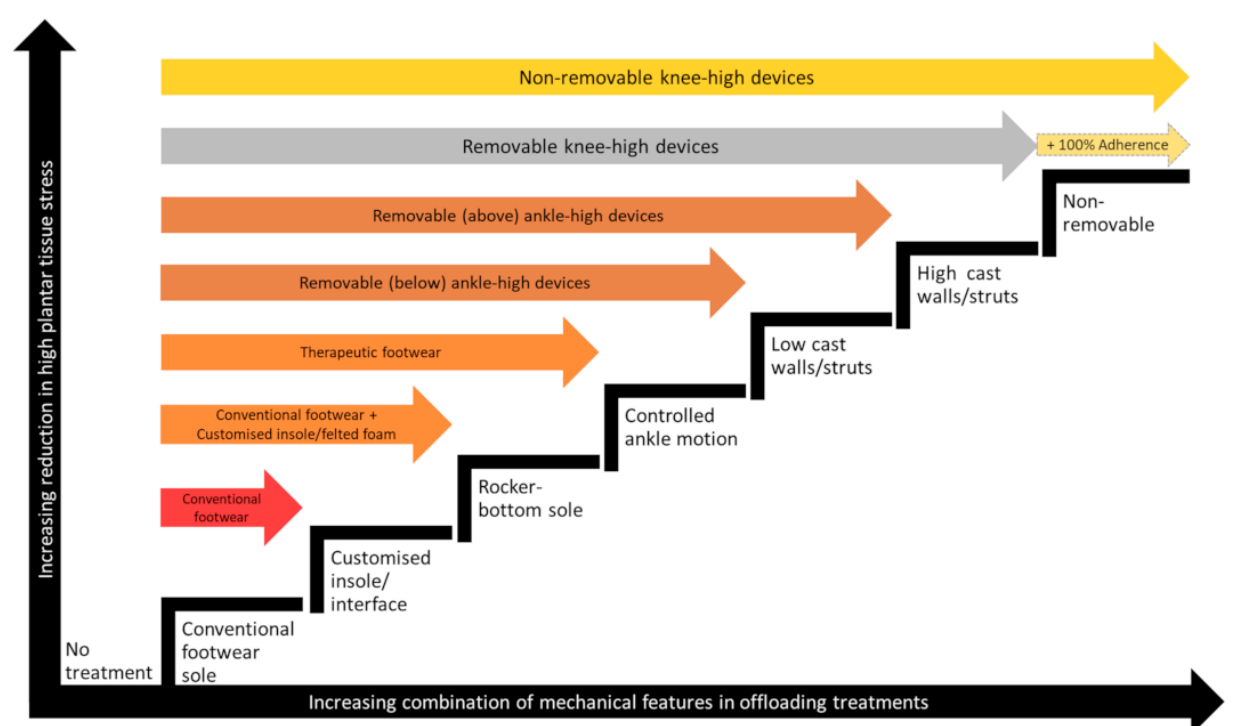
Figure 1. The stairway to best practice offloading treatment for people with diabetic foot ulcers. The figure is not to scale and is designed to illustrate the increasing capacity to re- duce high plantar tissue stress with the incorporation of additional mechanical features in different offloading treatments. Colored bars represent the mechanical features usu- ally incorporated in different offloading treatments: Gold = first-choice (gold standard); silver = second-choice; bronze = third-choice; orange= last-choice; red =